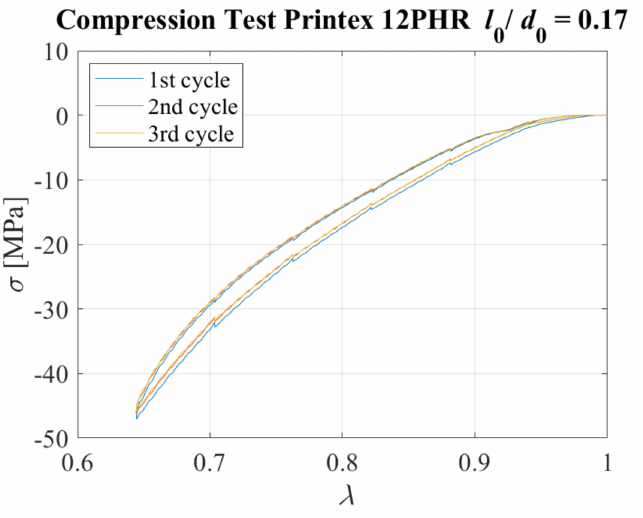
Figure 27. Compressive stress − strain curves for 3 cycles. Specimen with l 0 / d 0 =